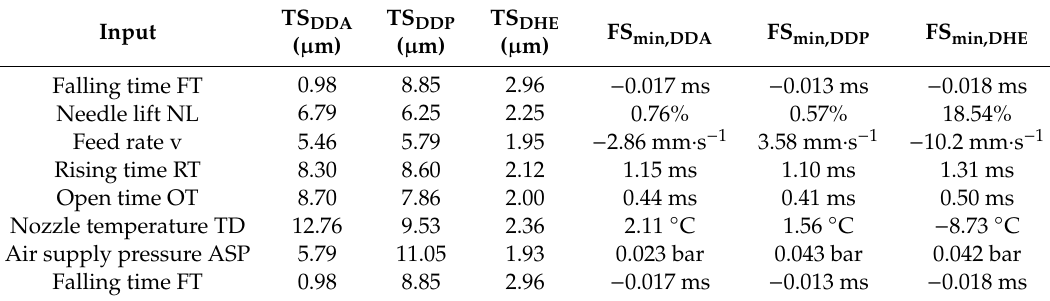
Table 2. Selectivities and minimum factor levels as a result of the preliminary tests.